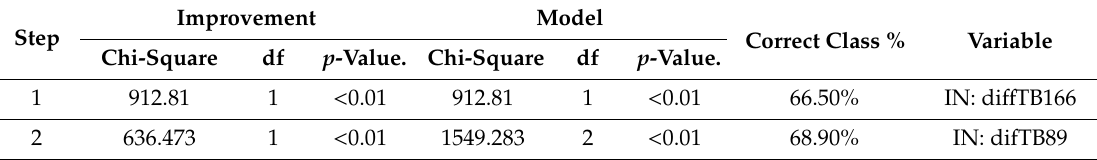
Table 3. Forward stepwise logistic regression model performances for di ff TB166 (step 1) and diddTB166 and di ff TB89 (step 2) as predictors. Each step shows results from the logistic regression model with a new additional predictor variable. “df” indicates the degrees of freedom, “Chi-square” represents the observed Chi-square test statistic value, and “Correct Class” represents the correct overall classification rate.